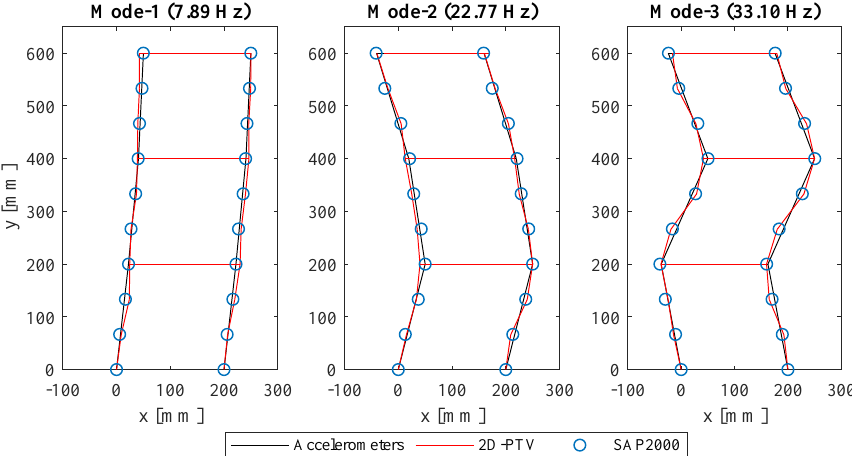
Figure 7. First three mode shapes obtained via accelerometers, 2D-PTV, and